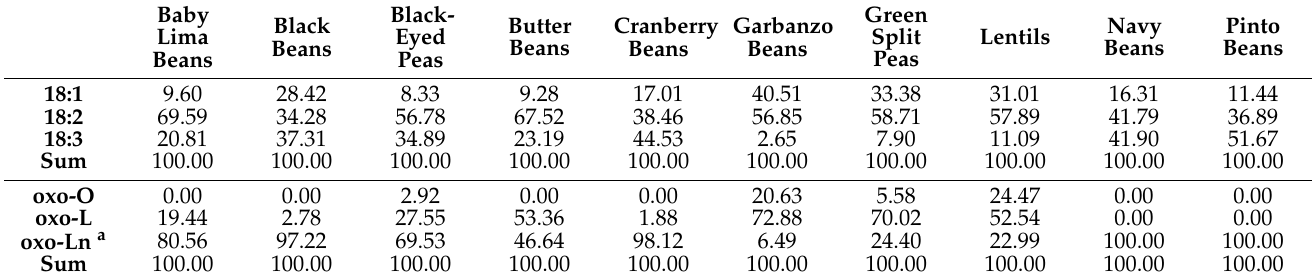
Table 3. Distributions of non-oxygenated unsaturated 18-carbon fatty acids and corresponding oxygenated 18-carbon fatty acids relative to their sums as determined from GC-FID peak areas. Isomers are grouped together.